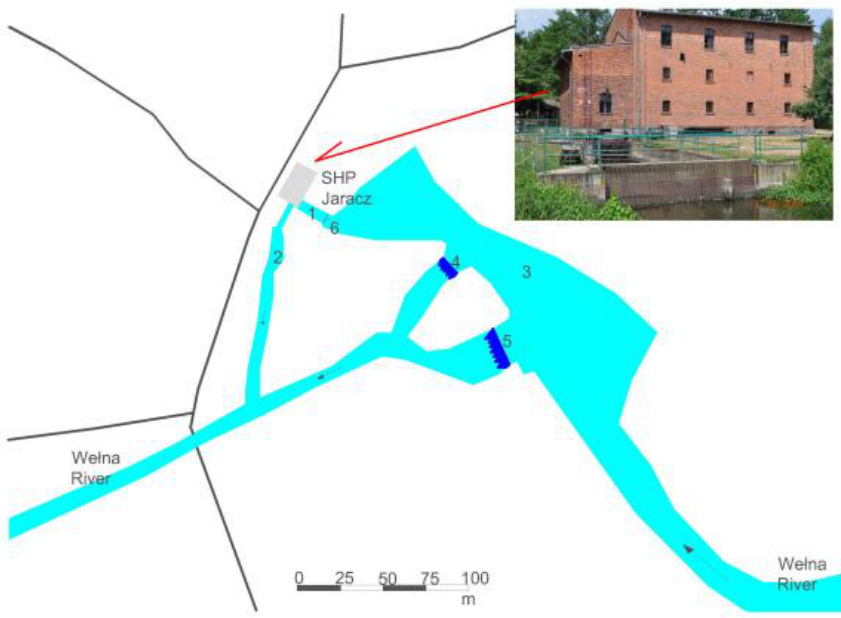
Figure 1. Situational plan with SHP in Jaracz.